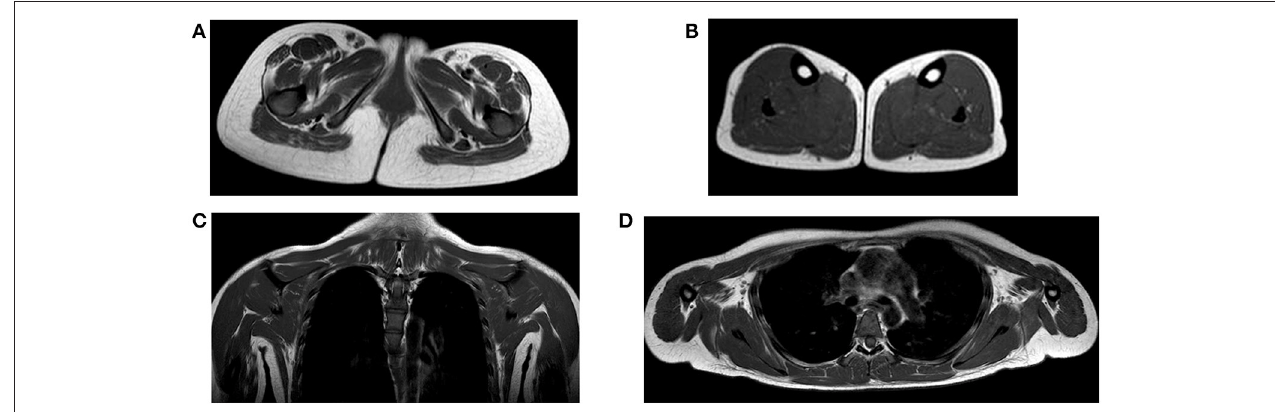
FIGURE 2 | (A) Axial T1 image at the pelvis showing atrophy and moderate fatty replacement involving the gluteus maximus, particularly on the right side (black arrow); (B) axial T1 MR image at the level of the calf showing the relative sparing of the muscles with only moderate involvement of the gastrocnemii lateralis (dotted white arrow); (C,D) coronal and axial T1 MR images at the level of the cingular girdle showing mild fatty infiltration in the subscapularis muscles.